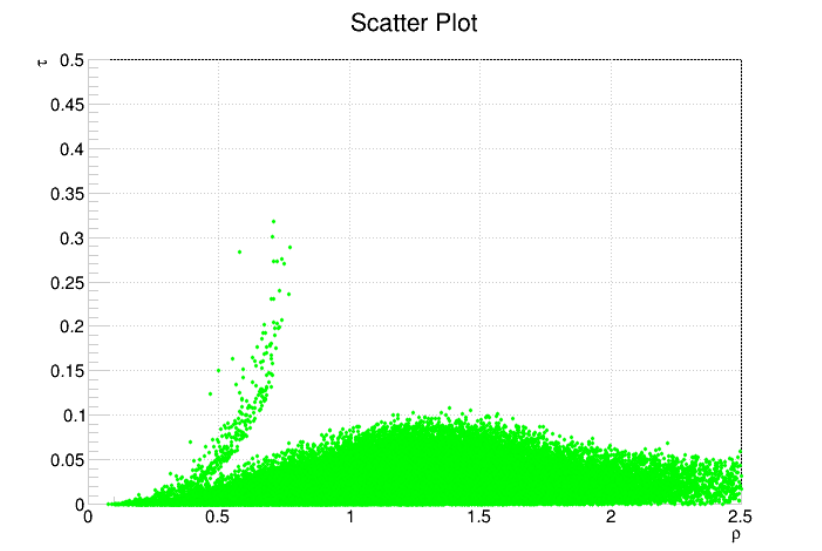
Figure 2 . Solution space in the (cid:28) (cid:0) (cid:26) directions.